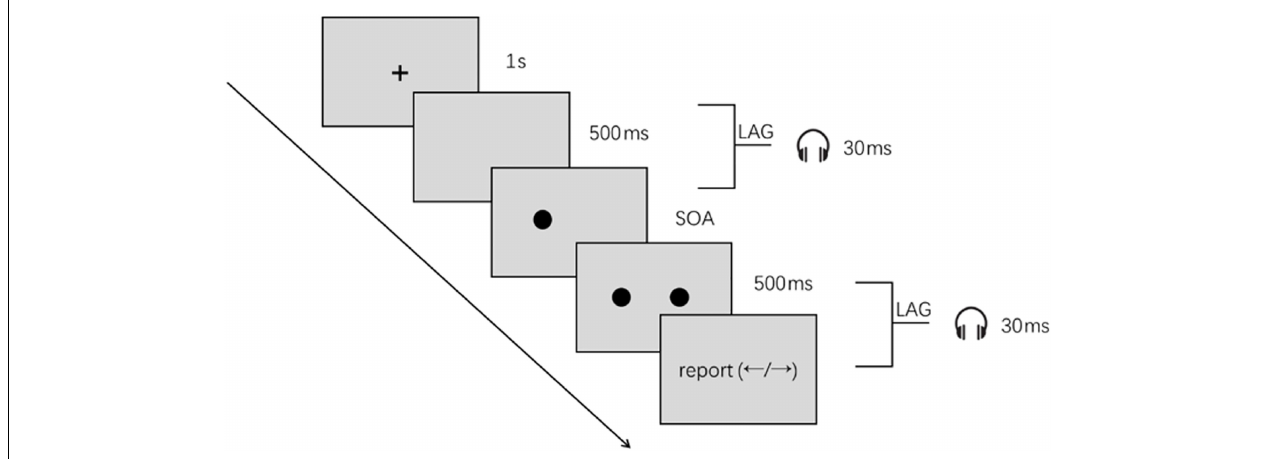
FIGURE 2 | Stimuli configuration and task procedure. A black fixation point was first displayed for 1 s in the center of the screen with a gray background. The fixation point then disappeared, and 500 ms later, the disks were successively shown and beeps presented according to the given settings of the current trial. The second disk was presented for 500 ms, and the two disks disappeared at the same time. The participants pressed the left or right key of the keyboard to report whether they thought the first disk was presented at the left or right side of the screen.